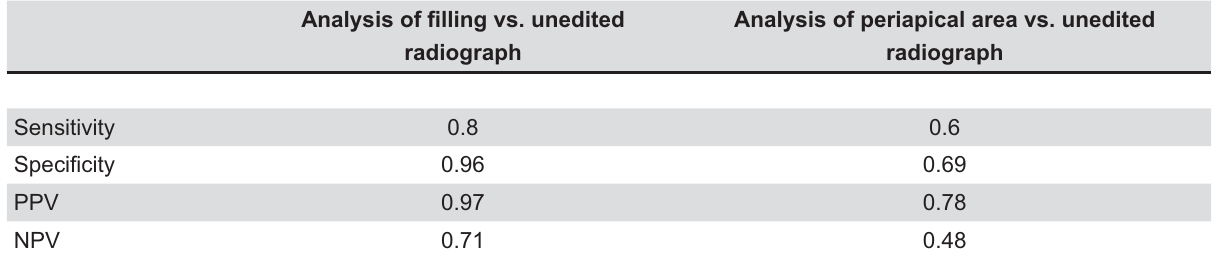
Table 2- (cid:4)(cid:6)(cid:16)(cid:17)(cid:12)(cid:18)(cid:13)(cid:18)(cid:26)(cid:18)(cid:13)(cid:28)(cid:7)(cid:4)(cid:12)=(cid:16)(cid:9)(cid:18)(cid:21)(cid:9)(cid:18)(cid:13)(cid:28)(cid:7)(cid:4)=(cid:20)(cid:12)(cid:18)(cid:13)(cid:18)(cid:26)(cid:16)(cid:4)(cid:22)(cid:17)(cid:15)(cid:4)(cid:17)(cid:16)!(cid:22)(cid:13)(cid:18)(cid:26)(cid:16)(cid:4)=(cid:27)(cid:16)(cid:15)(cid:18)(cid:9)(cid:13)(cid:18)(cid:26)(cid:16)(cid:4)(cid:26)(cid:22)(cid:23)(cid:14)(cid:16)(cid:12)(cid:4)(cid:29)(cid:20)(cid:27)(cid:4)(cid:27)(cid:16)(cid:13)(cid:27)(cid:16)(cid:22)(cid:13)((cid:16)(cid:17)(cid:13)(cid:4)(cid:15)(cid:16)(cid:9)(cid:18)(cid:12)(cid:18)(cid:20)(cid:17)(cid:12)(cid:4)(cid:22)(cid:9)(cid:9)(cid:20)(cid:27)(cid:15)(cid:18)(cid:17)!(cid:4)(cid:13)(cid:20)(cid:4)=(cid:22)(cid:27)(cid:13)(cid:18)(cid:22)(cid:23)(cid:4)(cid:27)(cid:20)(cid:20)(cid:13)(cid:4)